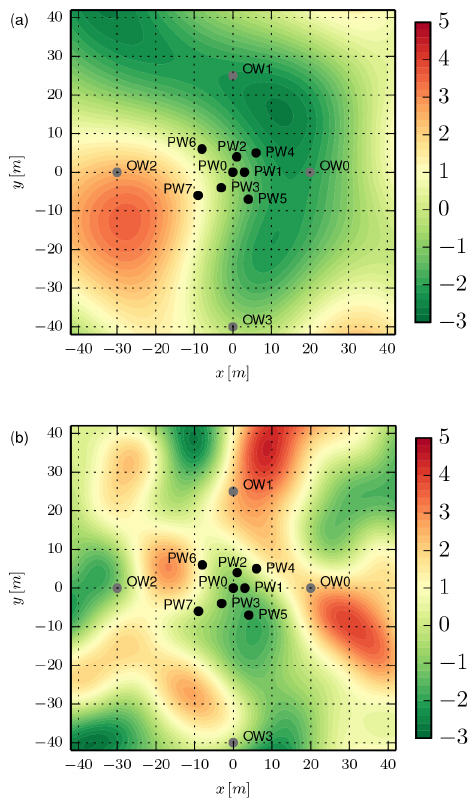
Figure 5. Spatial distribution of log-transmissivity for fields (a) D1 and (b) E1 and locations of the eight pumping wells (PW 0 , ... , PW 7 in black) and the four observation wells (OW 0 , ... , OW 3 in